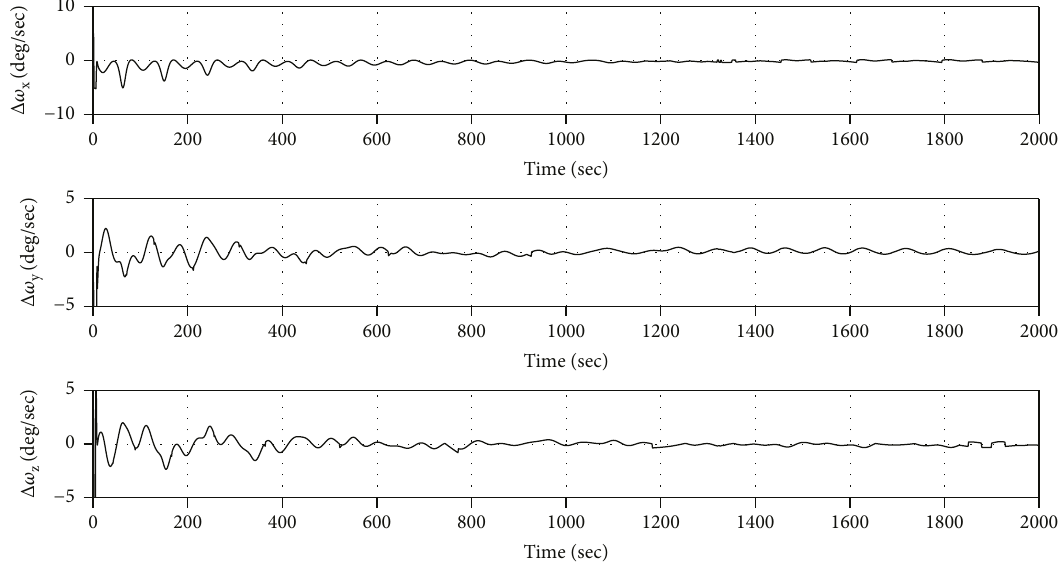
ω ω x , y , and z ) during Tigrisat